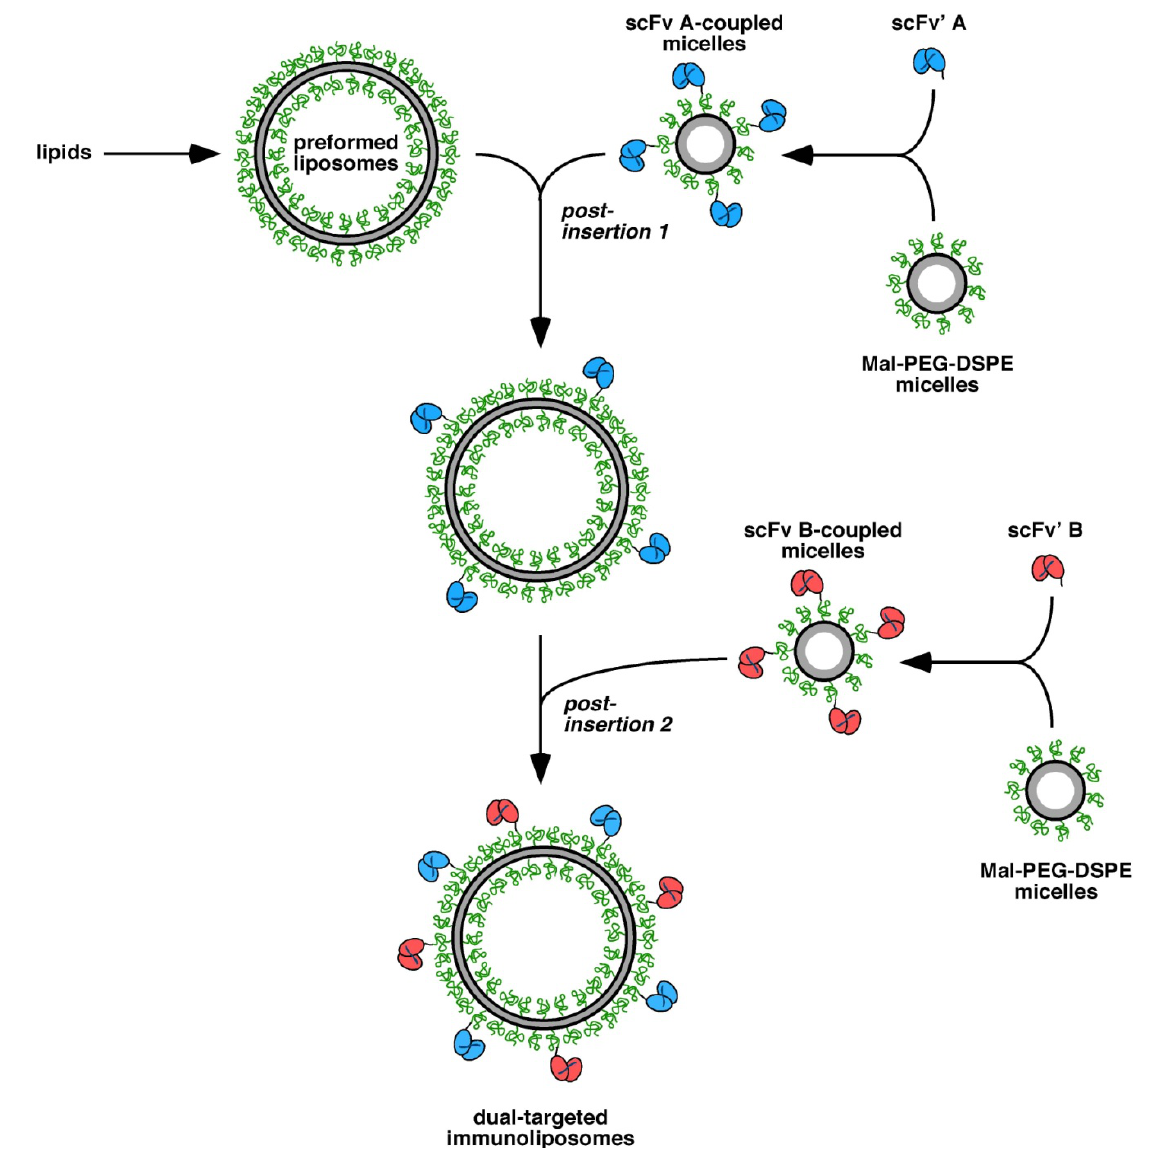
Figure 5. Schematic presentation of the generation of dual-targeted immunoliposomes applying a two-step post-insertion